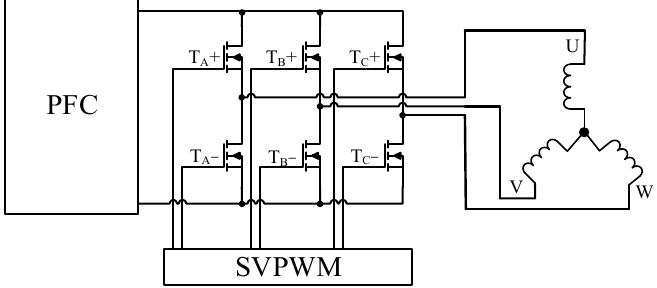
Figure 5. Main circuit of the 3-phase SVPWM inverter.